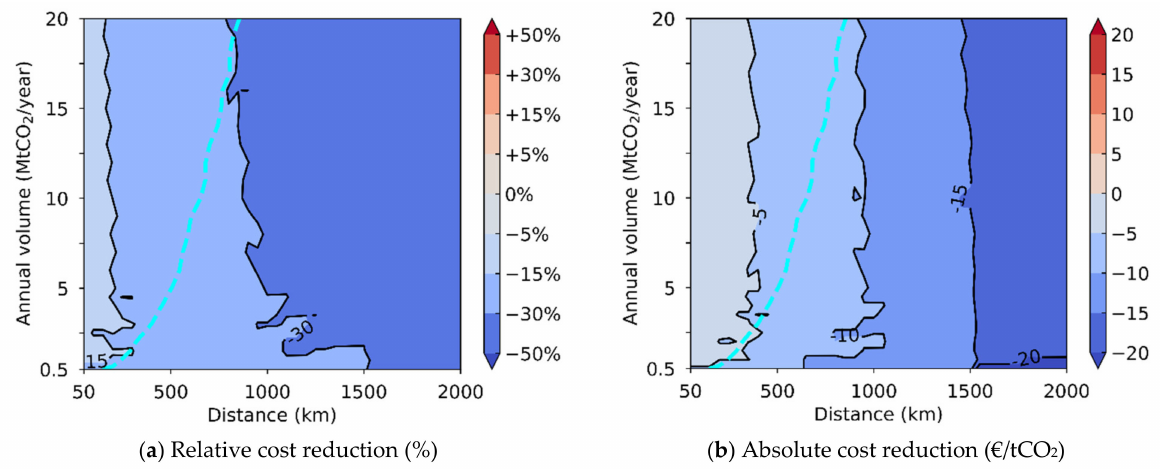
Figure 3. Cost comparison maps showing reductions enabled by the 7 and 15 barg shipping for transport between two